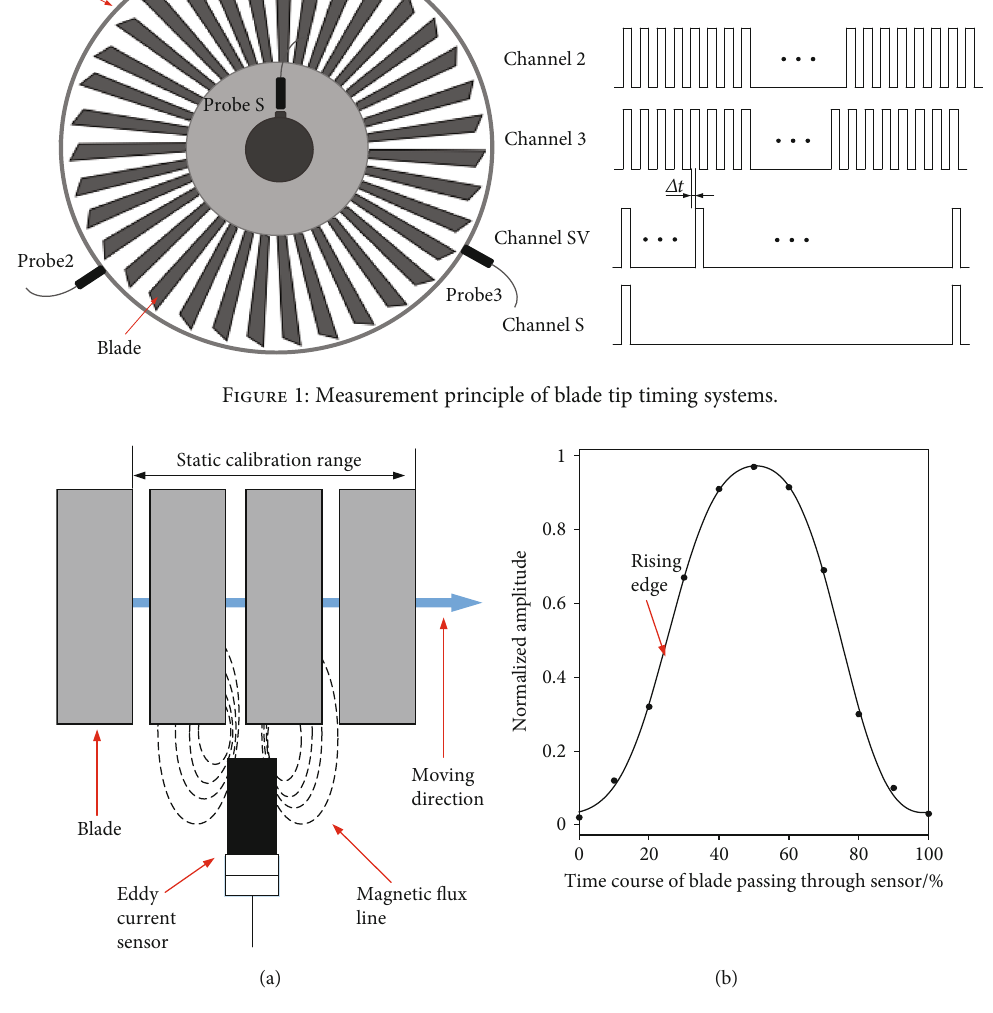
Figure 2: Calibration for BTT sampling